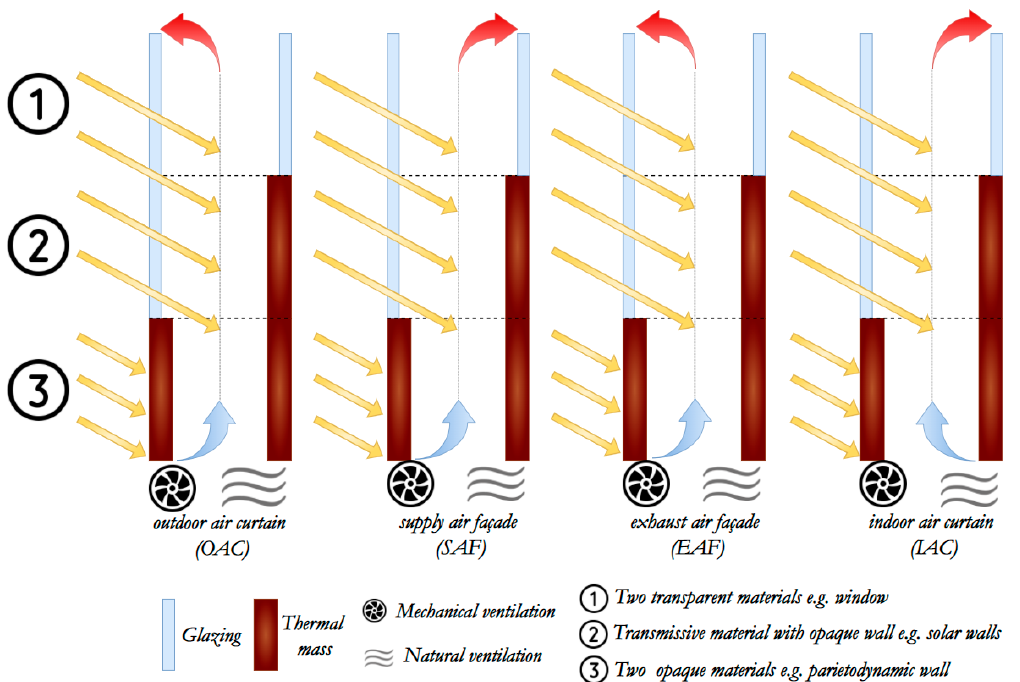
Figure 1. Solar façade types (inspired by [12–15]).